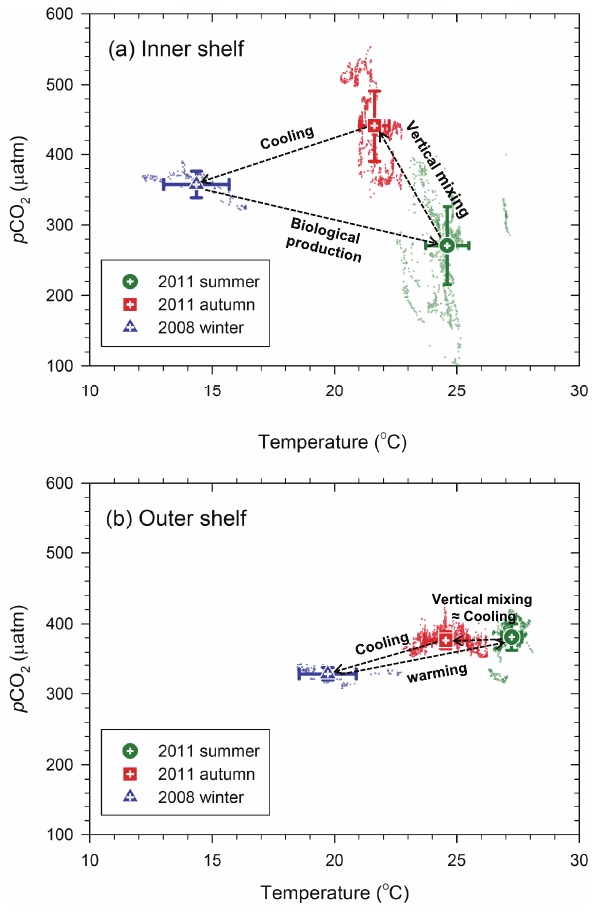
Fig. 5. Plots of p CO sw vs. temperature for summer 2011, autumn 2 2011, and winter 2008 data in (a) the inner shelf area and (b) the outer shelf area. The definitions of the inner and outer shelf areas are the same as in Fig.